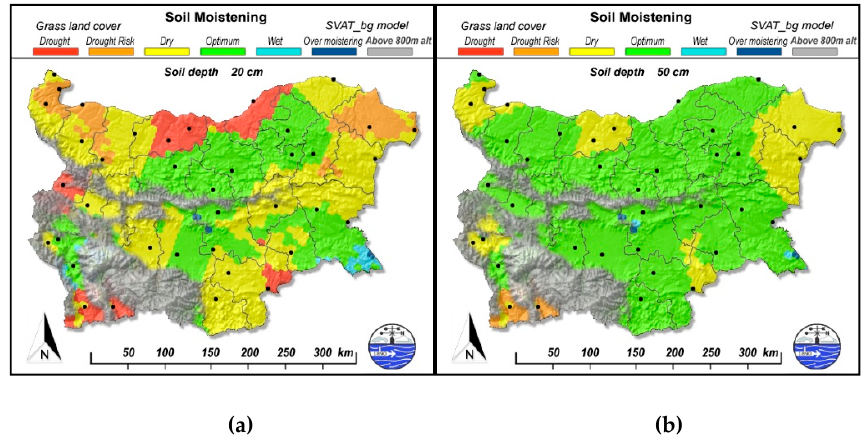
Figure 1. Example of color-coded maps of SMAI over Bulgaria for ( a ) 0–20 cm soil layer; ( b ) 0–50 cm soil layer. The symbol ( · ) indicates the location of synoptic stations used for SVAT model running. Mountain regions are excluded.